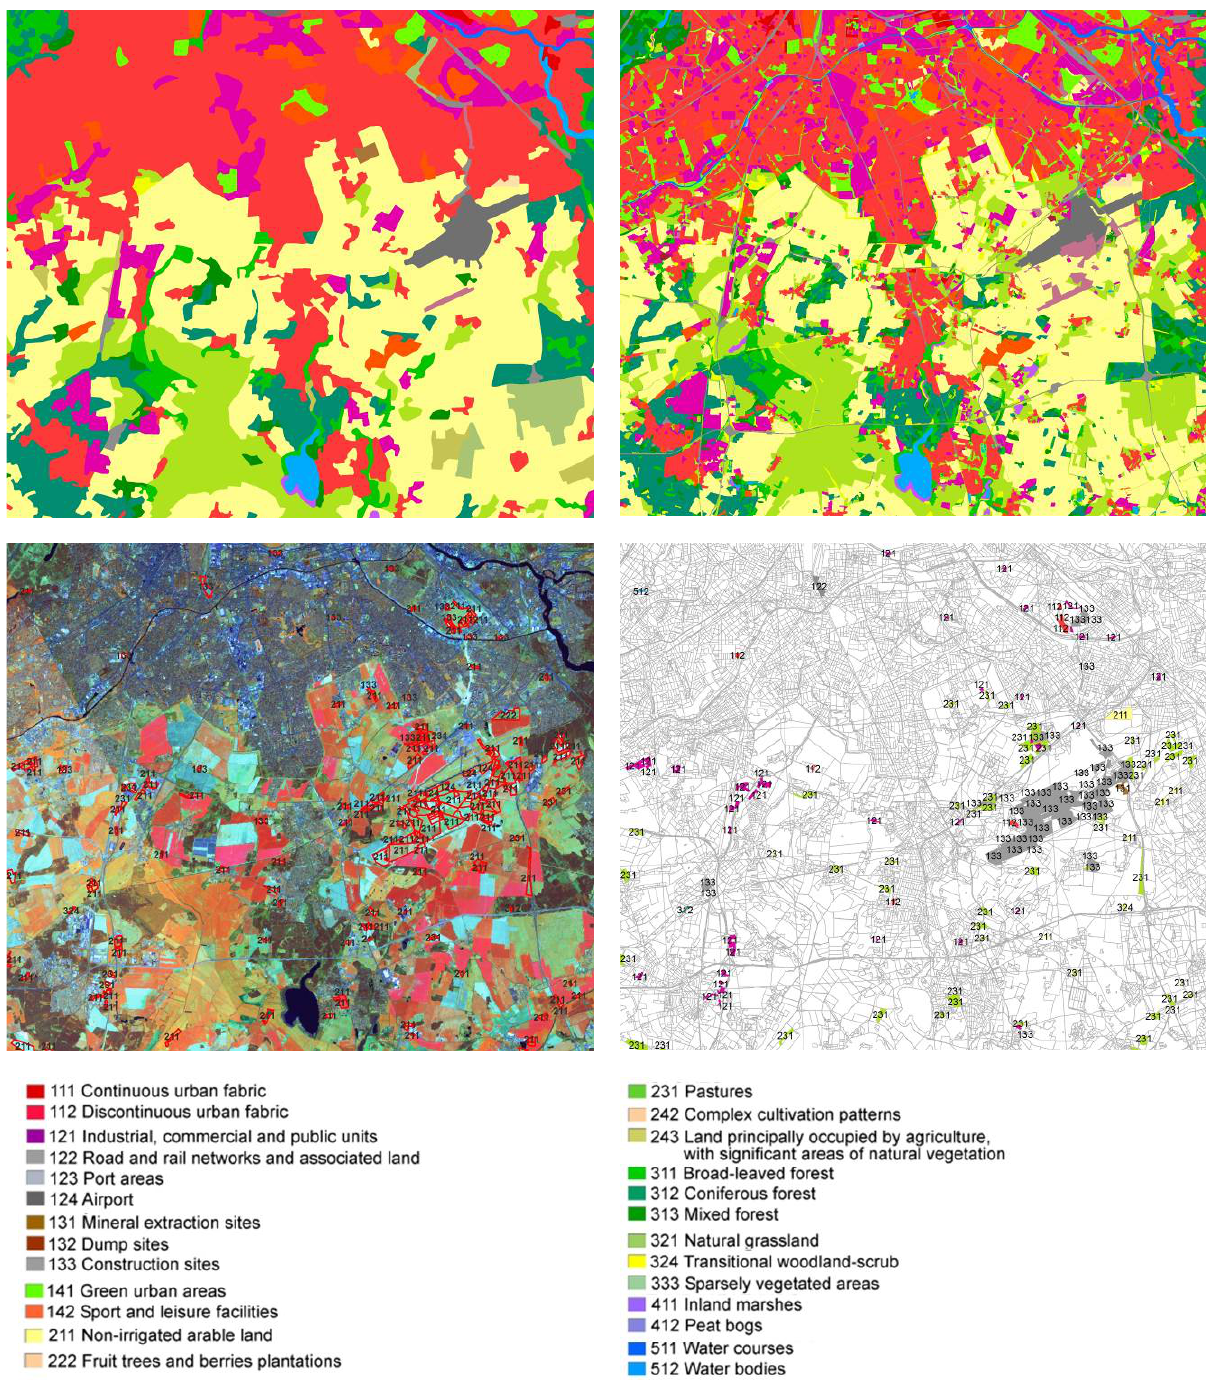
Figure 4: Exemplary results: Southern parts of Berlin and the adjoining region in Brandenburg with the area of the Berlin- Brandenburg International Airport (Airport Berlin Schönefeld) under construction. Upper left: CLC2006 with 25 ha MMU; upper right: derived DLM-DE2006_Backdating with 1 ha MMU. Center left: LISS-III subscene from spring 2005, with overlay of change polygons (red) labelled with the status of 2006; center right: polygons of DLM-DE2006_Backdating (in grey) with coloured parts of change areas, in the status of 2009. Lower left and lower right: Colour legend of the occurring CLC classes in CLC2006 and DLM-